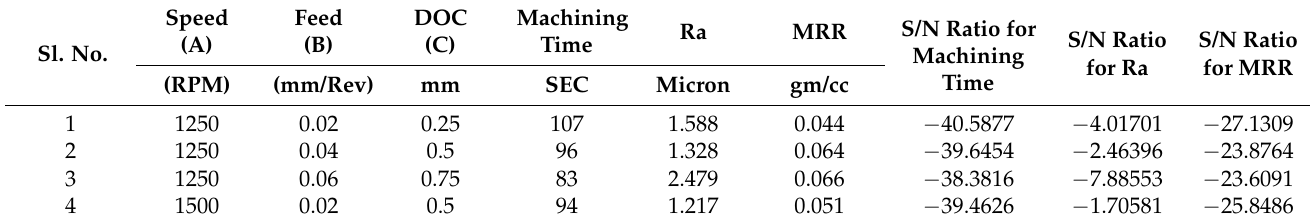
Table 8. Orthogonal array (L9) with S/N ratio for machining time, surface roughness, MRR. Sl.